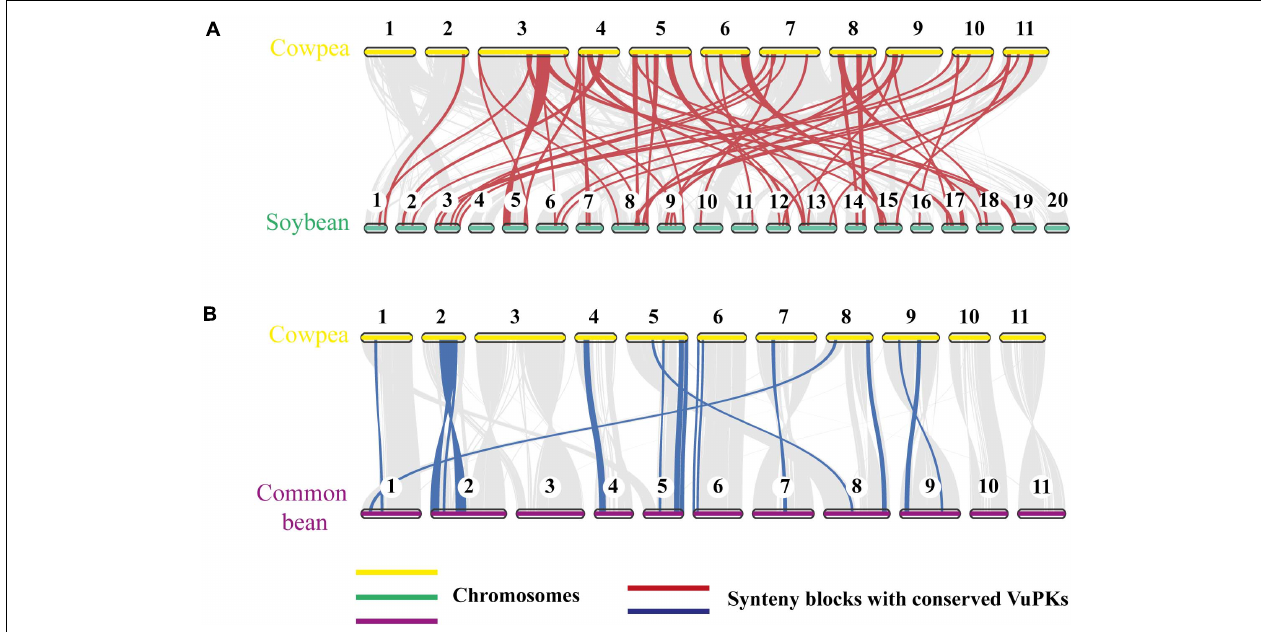
FIGURE 5 | Comparative genomics between (A) cowpea vs. soybean and (B) cowpea vs. common bean. The red and blue lines connect syntenic blocks with bona fide VuPK-encoding loci. The gray wedges in the background highlight major syntenic blocks spanning at least five genes between the